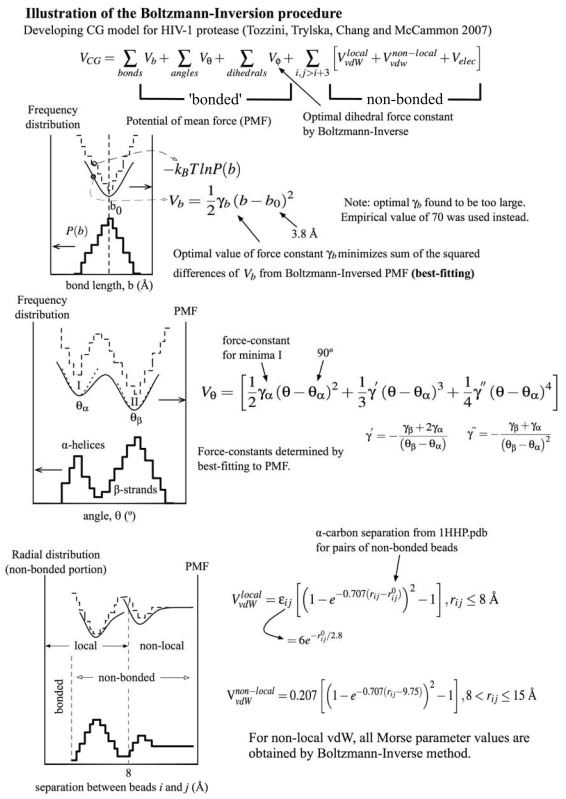
Parameterization of the force-field of the TTC model of HIV-1 protease, based on the Boltzmann-Inversion procedure. The distribution for angles involved in β-strands is bi-modal but is single-modal when specific residue sequences are considered. With θα and θβ determined, force constants are optimized via least-squares-fit procedure. Dihedral potential is assumed harmonic, with the force constants taken from BI but equilibrium dihedral angles taken from the reference structure. Lastly, for the non-bonded vdW interactions, there is one PMF well for the non-local part (>8 Å) but multiple ones, of which equilibrium distances are taken from pair separations (rij0) of beads in the reference structure, for the local part (within 8 Å).